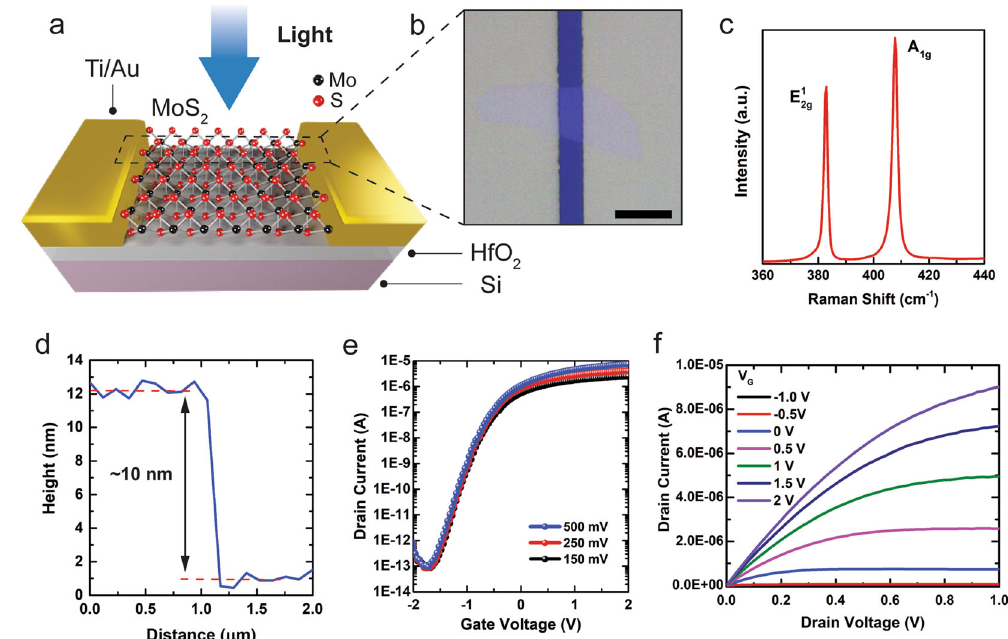
Fig. 1 Device structure and characterization. a Device schematic of back-gated MoS 2 phototransistor. b Close-up optical microscopic image of MoS 2 channel region. Scale bar 10 μ m. c Raman spectrum of multi-layered MoS 2 . The wavenumber difference between the in-plane E 1 modes was 24.8 cm − 1 . d AFM height pro fi le of MoS 2 indicating fi lm thickness of 10 nm. e Dark condition transfer characteristics of the MoS 2 phototransistor at different drain voltages: 150, 250, and 500 mV. f Dark condition output characteristics of the MoS 2